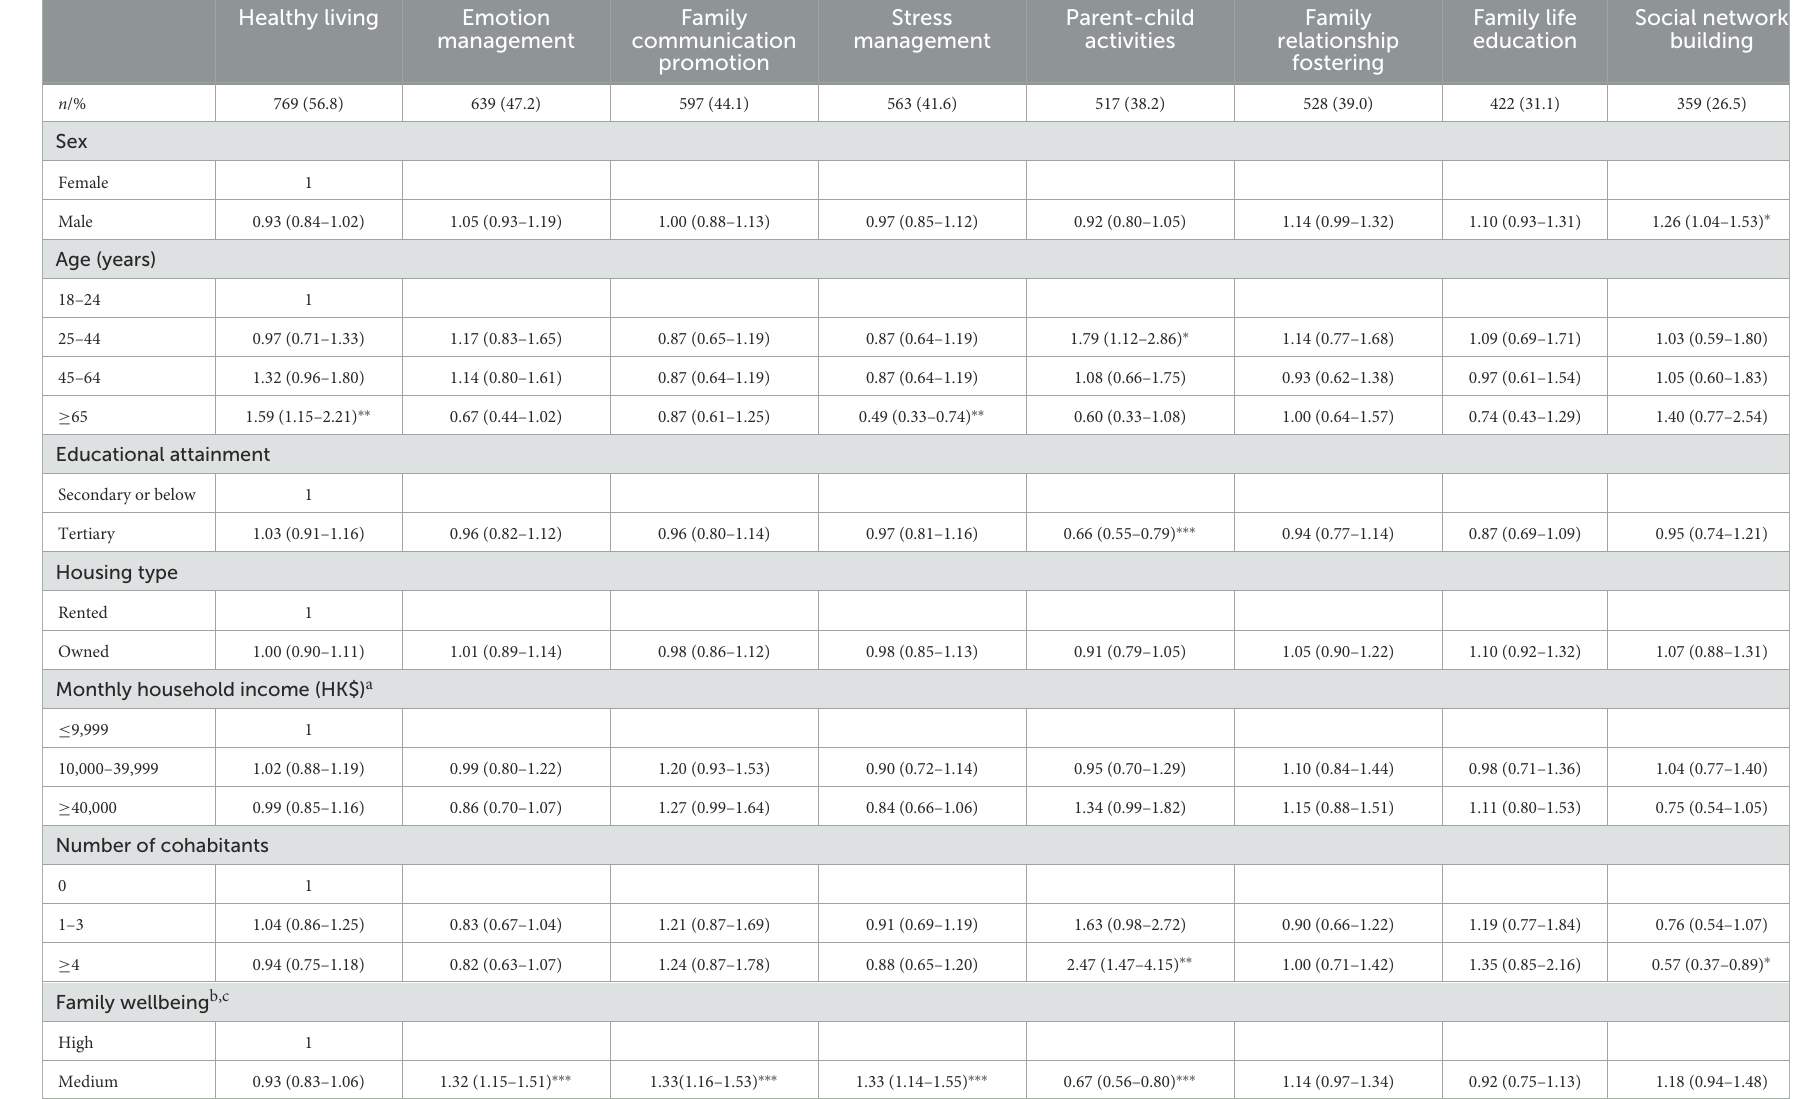
TABLE 3 The associations of preferences of family services with sociodemographic characteristics, family wellbeing, and family communication quality, aPR (95% CI) ( N =